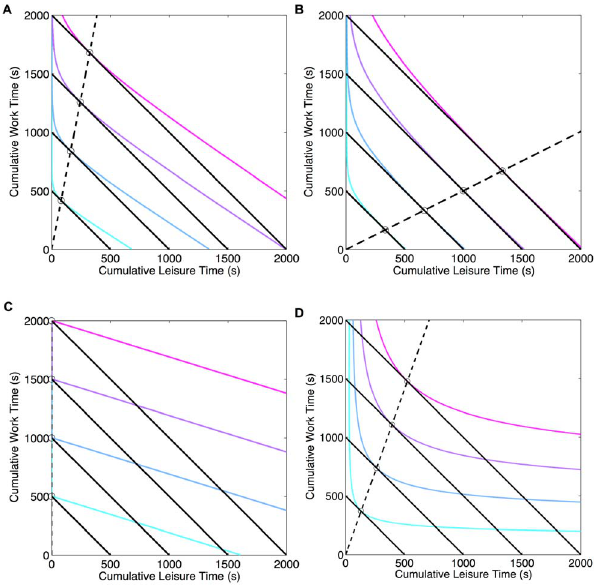
Figure 4. Microscopic choices yield macroscopic partial allocation even with independent marginal utilities. To compare directly with labor supply theory, we derive macroscopic utility functions consistent with our assumed microscopic utiities. Curves show indifference curves of the derived macroscopic utility function. Cool colours show order of increasing macroscopic utility. Solid black lines show different budget constraints T ~ v z l as T is changed. Dashed black line denotes the path through theoretically predicted optimal leisure and work combinations as T is increased. A), B) Stochastic, approximately optimal microscopic choices with linear C L ( : ) yields partial allocation (A) high and B) medium payoffs are shown). Inverse temperature b ~ 1 . C) Deterministic, optimal microscopic choices with linear C L ( : ) yield all-or-none allocation–work all the time if RI w K L P . Inverse temperature b ? ? . C L ( t L ) ~ 0 : 7 t L , Reward intensity, RI ~ 9 in A), RI ~ 4 : 3 in B) and C), price P ~ 4 s in A-C. D) Deterministic, optimal choices with non-linear C L ( : ) also yields partial allocation. C L ( t L ) ~ 0 : 7log( t L ) , b ? ? , RI ~ 2 : 46 and price P ~ 4 s.